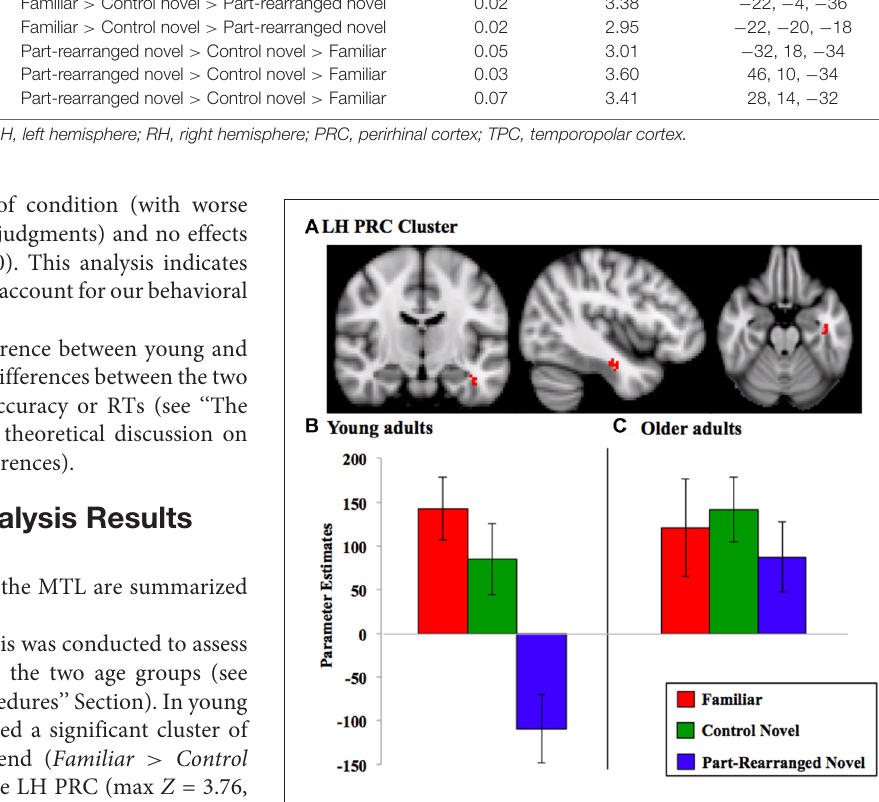
FIGURE 4 | Perirhinal cortex (PRC) linear trend cluster analysis results. (A) PRC cluster (in red) that exhibited a significant linear pattern of activation for RVF presentation in the direction Familiar > Control Novel > Part-Rearranged Novel in the young participants. Parameter estimates extracted from this cluster for each condition are shown for (B) young and (C) older adults. Note that the cluster shown in (A) was identified via a voxelwise analysis for the group of subjects, whereas the parameter estimates were later calculated for each condition across the spatial extent of that cluster. Hence, the data in (B) are for illustrative purposes only; they are not an exact representation of the data submitted to the group level GLM analysis that produced the cluster. Error bars represent standard errors of the mean. LH, left